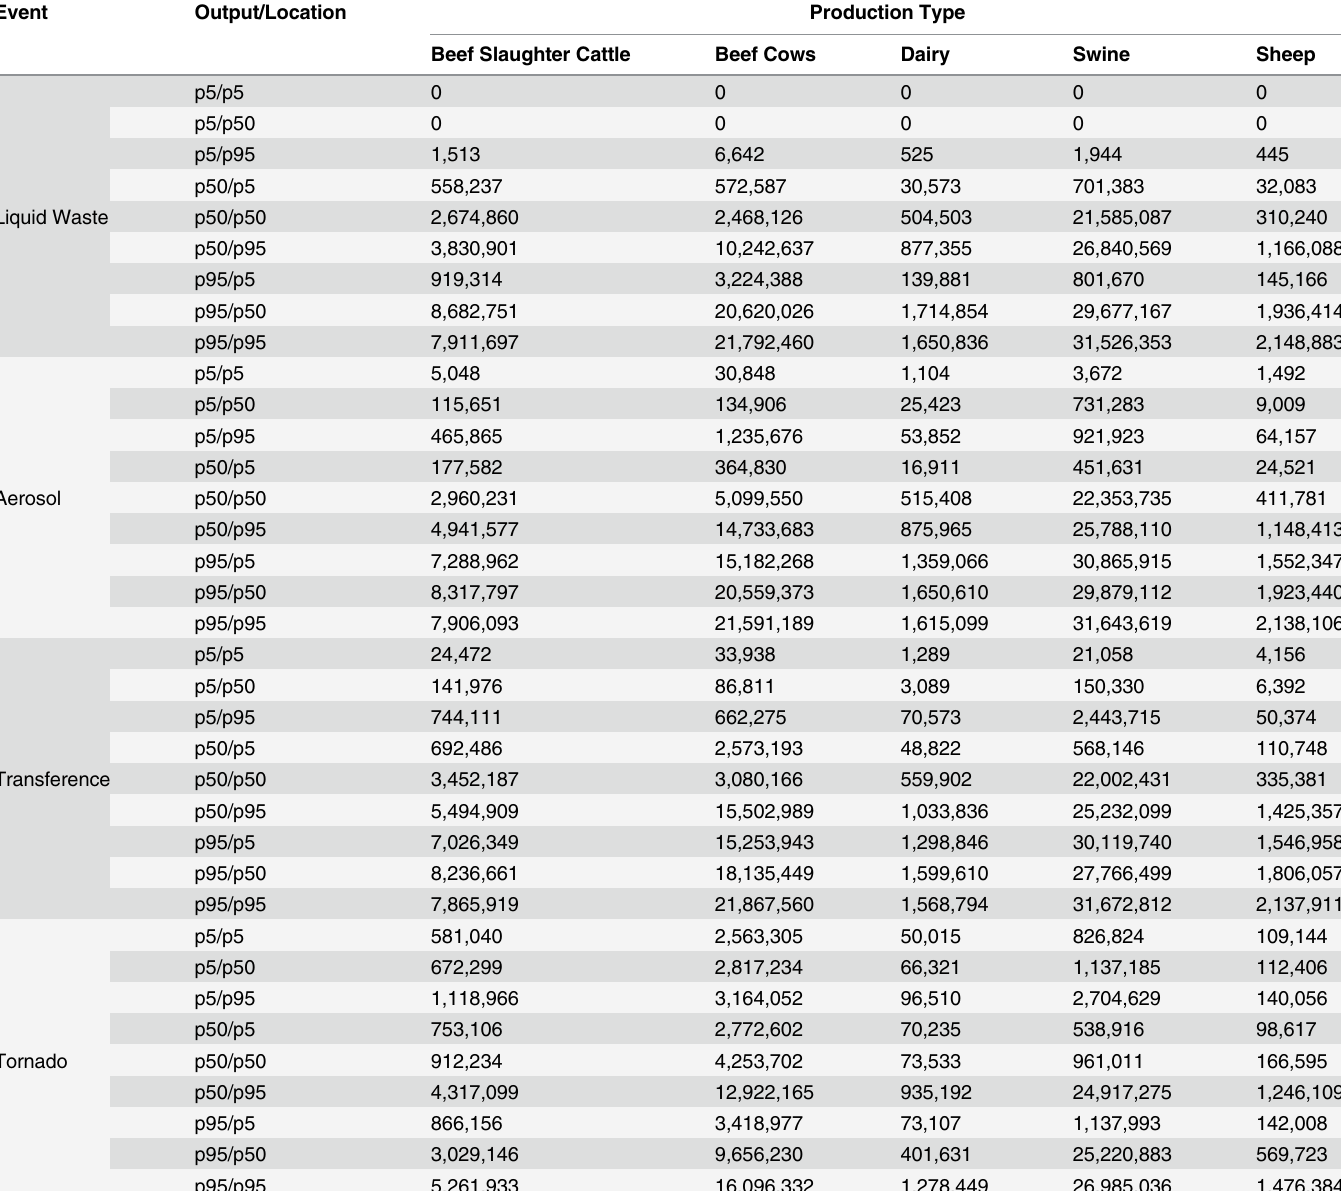
Table 4. Number of Animals Vaccinated by Production